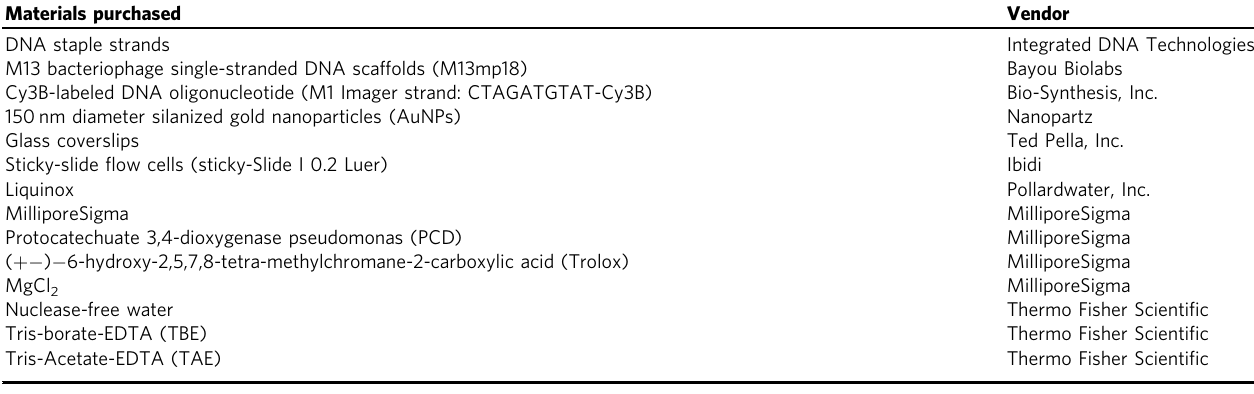
Table 1 Materials. Materials purchased Vendor DNA staple